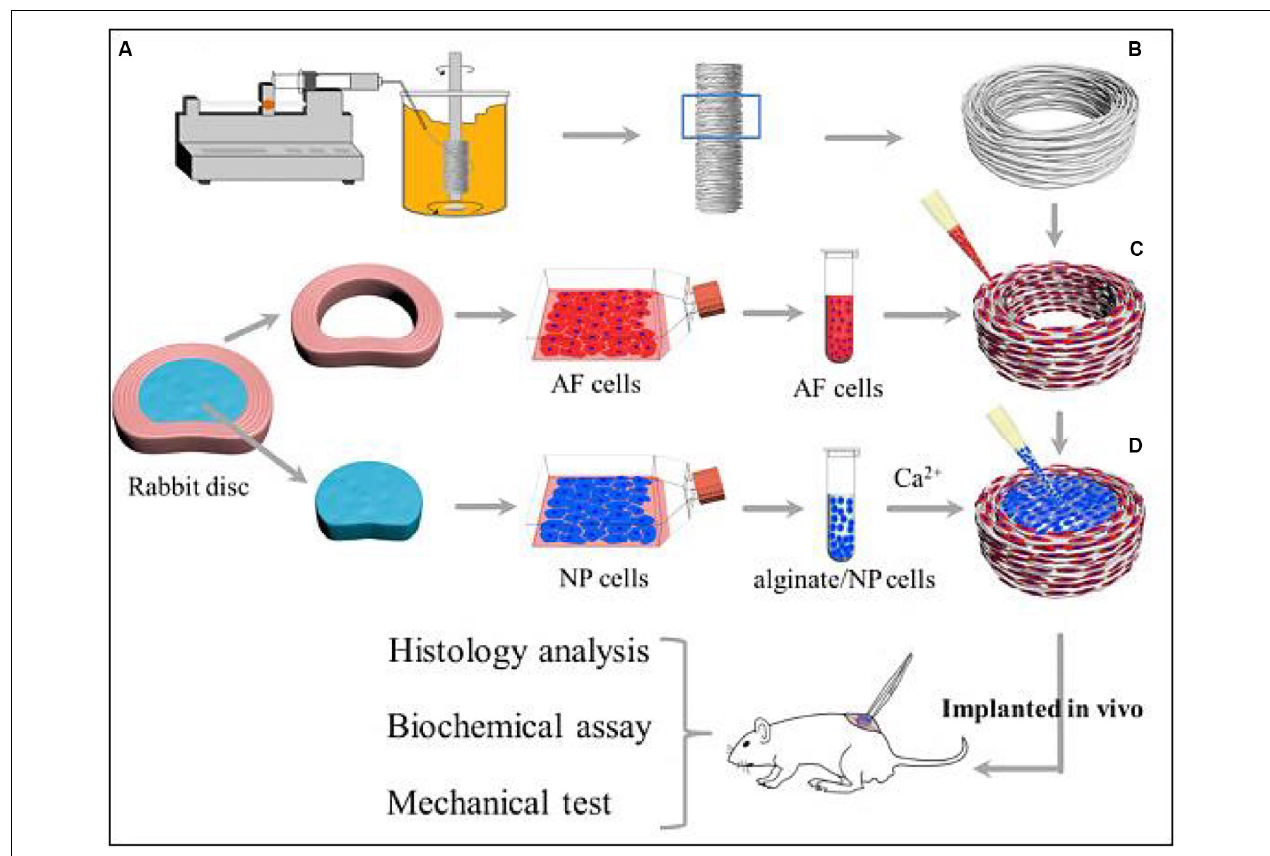
FIGURE 3 | Schematic illustration shows the construction of composite TE-IVD and the design of in vitro study and in vivo implantation into nude mice. (A) Wet spinning process. (B) Circumferentially oriented PCL AF scaffold. (C) Seeding cells to the AF phase. (D) Injecting alginate containing cells into the NP phase. Reproduced from Du et al. (2019) with permission from Copyright 2019